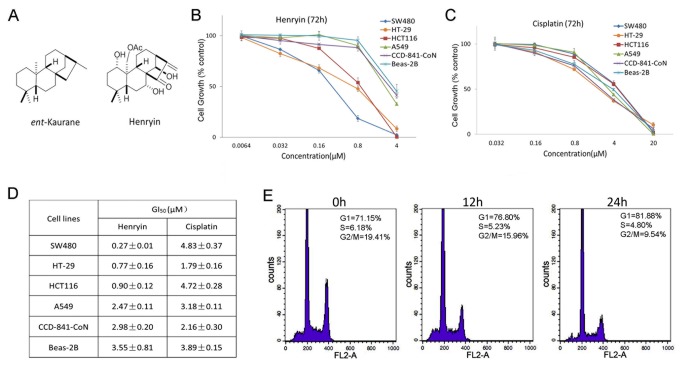
Henryin selectively inhibits the growth of colon cancer cells and induces G1 phase arrest.(A) The structures of henryin and ent-kaurane are shown. (B) Growth inhibition of henryin on various cell lines, including colorectal cancer cell lines (SW480, HCT116 and HT29), normal colonic epithelial cell line CCD-CoN-841, lung cancer cell line A549, and normal lung epithelial cell line Beas-2B, determined by MTS assays with cisplatin used as a control (C). Cells were treated with henryin up to 72h at various concentrations. The absorbance was measured at 490 nm. All sampling was done in triplicates and the data are presented as mean ± SD. (D) The median growth inhibition concentration (GI50, 72h) values of henryin and cisplatin for various cell lines. (E) Representative histograms depicting cell-cycle distribution as analyzed by flow cytometry in HCT116 cells treated with 4µM of henryin for 0h, 12h and 24 h respectively. Counts of G1 phase cells increased remarkably in the treated cells in a time-dependent manner.